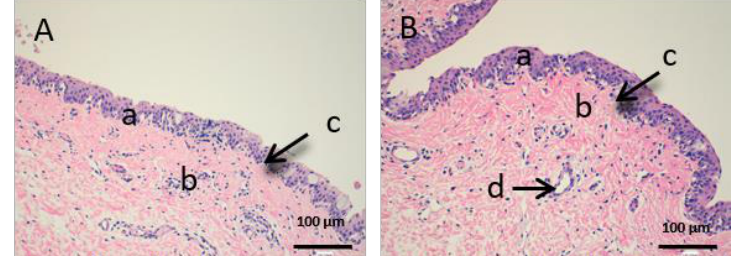
Figure 10. Histological images of conjunctive mucous. ( A ): Untreated conjunctive mucous observed at 400× and ( B ): Conjunctive mucous treated with CP-Sat observed at 400×. a: stratified flat keratinized epithelium; b: own laminate and c: hair follicle.